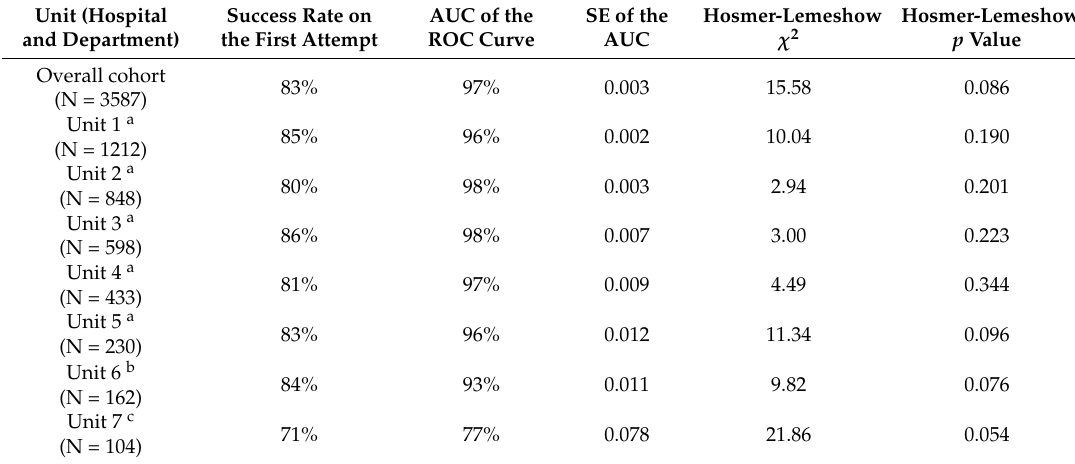
Table 5. Comparison of the level of performance of the modified A-DIVA scale in the different included